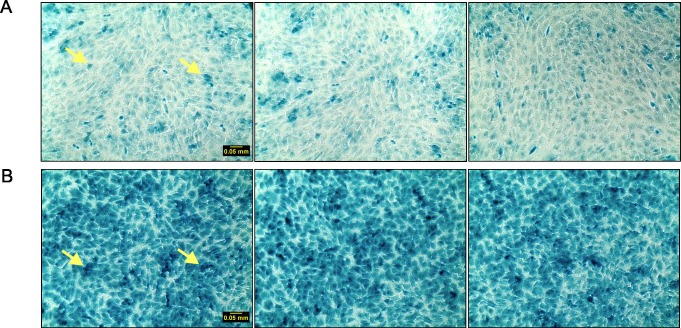
Senescence-associated β-galactosidase staining in EA.hy926 cells grown on Matrigel-coated or plastic culture plates.EA.hy926 endothelial cells were seeded on Matrigel-coated (Panel A) or plastic plates (Panel B) at 9000 cells/cm2 and grown for 10 days. SA-β-Galactosidase Staining was performed on cells and 3 representative images are shown per condition. The arrows in the first image of Panel A and Panel B indicate cells with a high level of SA-β-galactosidase staining.